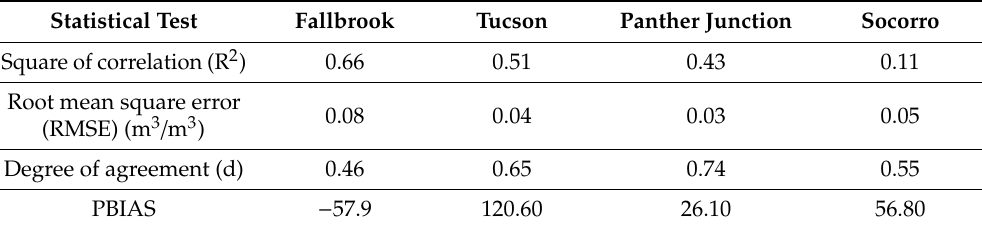
Table 3. Results of comparison at selected sites of North